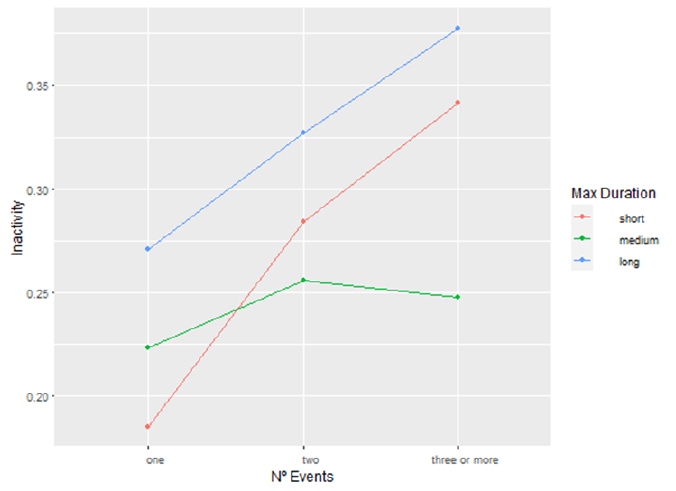
Figure 2. Plot representing the effect of the interaction between N° events and max duration on daytime inactivity of the chimpanzees. Each point on the plot is a predicted mean inactivity value and each connection between two points describes the effect, based on the data of the inactivity LMM model with N° events, max duration, sex, age category, and the interaction of N° events, max duration as fixed factors.